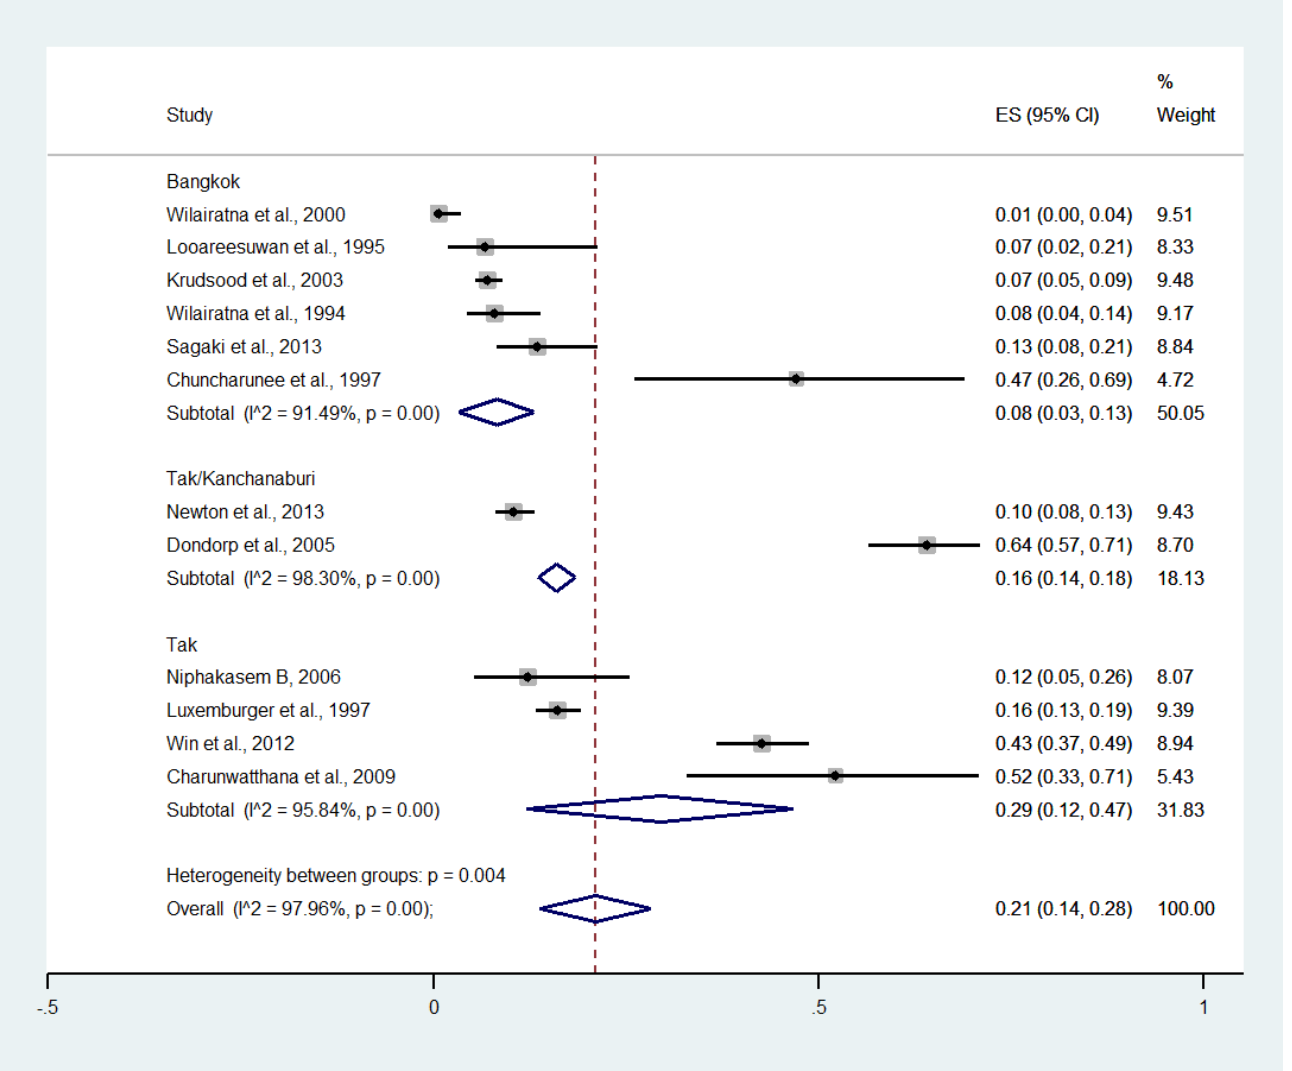
Figure 7. Subgroup analysis of the pooled prevalence of impaired consciousness among patients with severe malaria in Thailand. The label for the x-axis is the scale of estimated prevalence. Abbreviations; ES, estimated prevalence; CI, confidence interval .